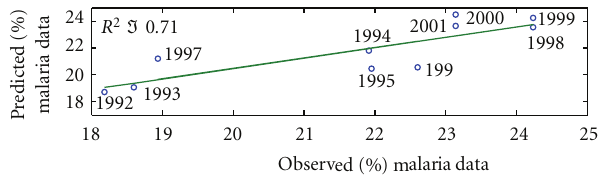
Figure 6: Correlation between independently predicted and observed number of malariacases (% of malaria cases from the total number of people who come to the regional hospitals with fever).